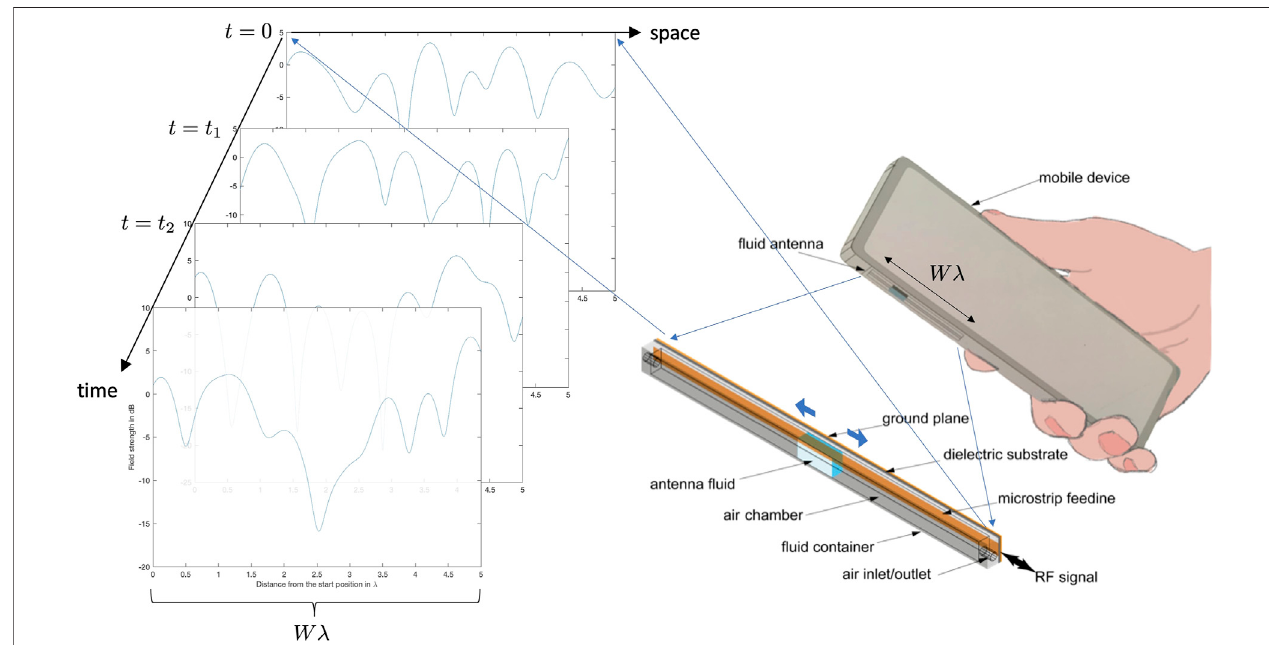
FIGURE1 | An illustration ofahandset equipped with atube-like fl uid antenna system and its potential capability in browsing through the various fading envelopes in space. This fi gure also shows the different fading envelopes a fl uid antenna sees over its entire space at different time instants.